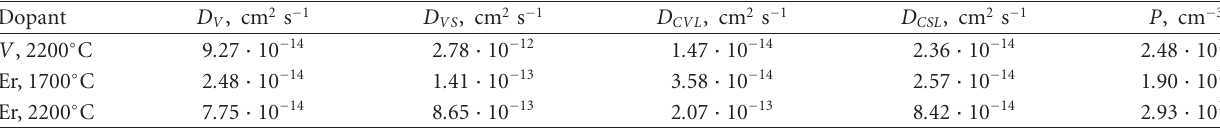
Table 1: Di ff usion parameters obtained from the